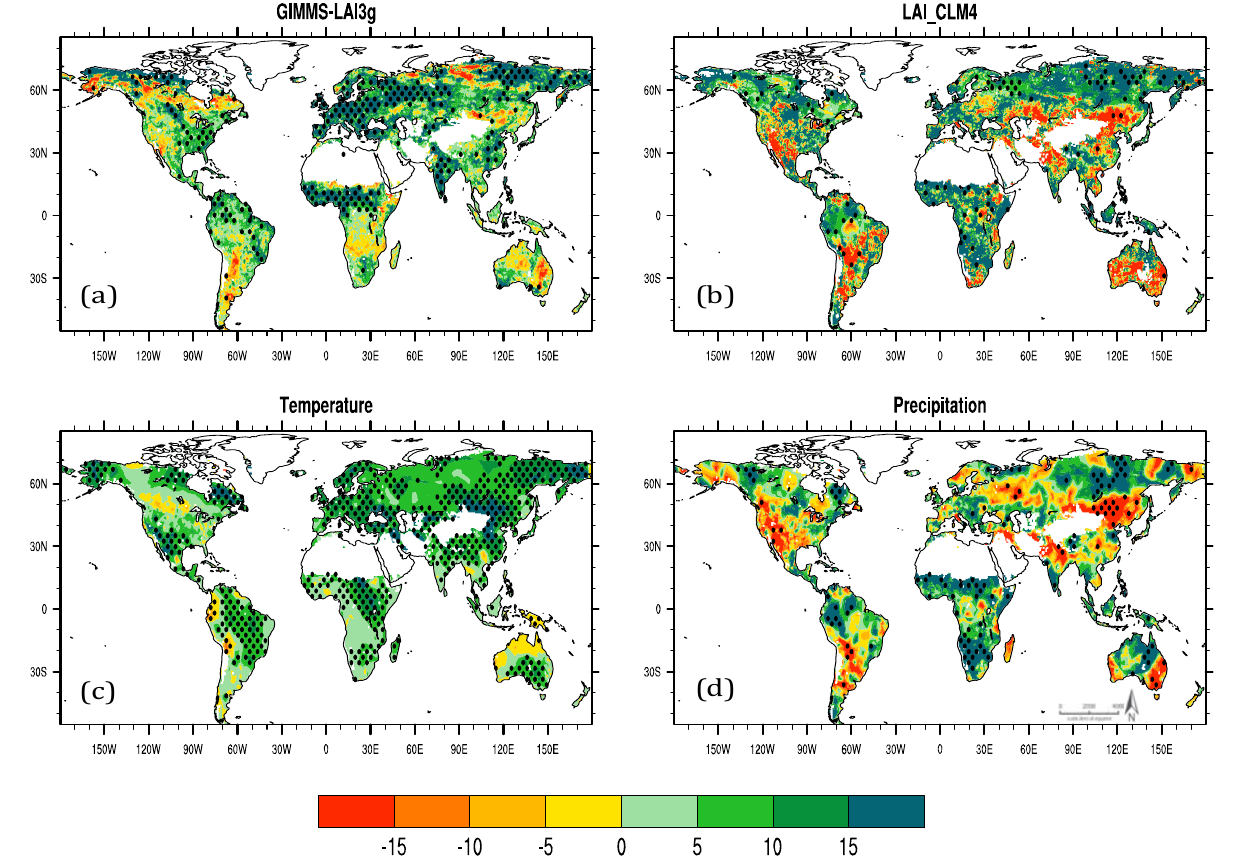
Figure 2. The spatial distribution pattern of the relative trend (%/28 yr) in ( a ) GIMMS-LAI3g; ( b ) CLM4_LAI; ( c ) temperature; and ( d ) precipitation. The stippled areas represent the changes are statistically significant (P < 0.05). The temperature trend in (c) is scaled by multiplying 25 for direct comparison